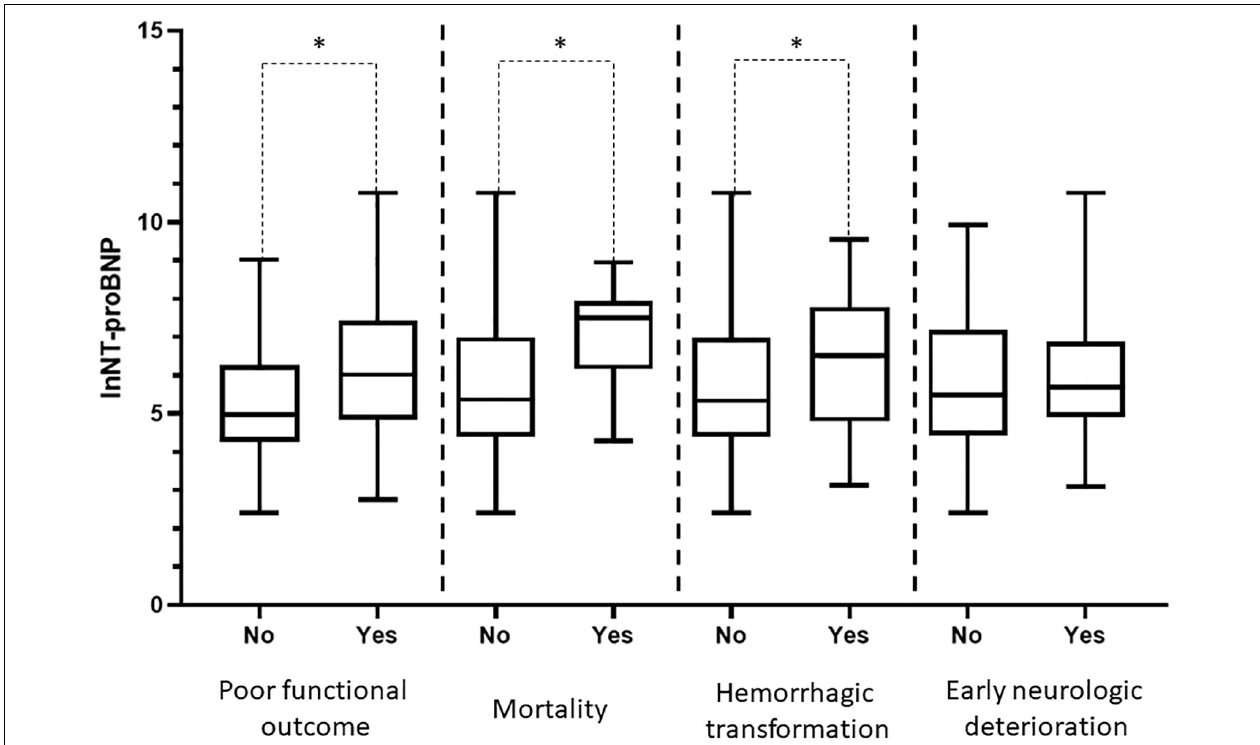
FIGURE 2 | N-terminal pro-brain natriuretic peptide (NT-proBNP) in poor functional outcome, mortality, hemorrhagic transformation, and early neurologic deterioration. One hundred seventy-seven patients had good functional outcomes and 227 had poor functional outcomes; 30 patients died, 374 survived; 72 patients had hemorrhagic transformation, 332 not; 31 patients had early neurological deterioration, 373 not. Distribution of NT-proBNP was depicted with natural log transformations, which was depicted with median and interquartile range. Patients with poor functional outcome, mortality, and hemorrhagic transformation had higher NT-proBNP levels compared with patients without. ∗ P <